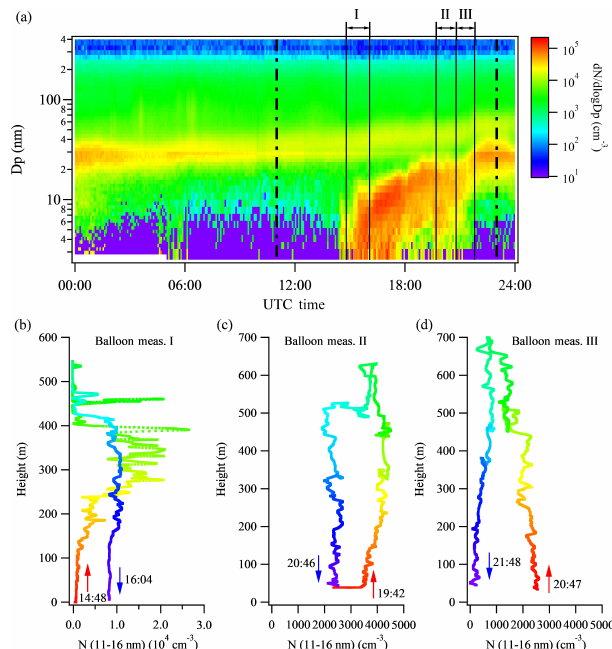
Figure 3. New particle formation event on 12 May 2013 at SGP. (a) Particle size distributions captured by ground-based scanning mobility particle sizers. The two vertical dashed lines represent 06:00 and 18:00 local time, respectively. The vertical black solid lines represent the time frames of the tethered balloon measure- ments. (b–d) Vertical profiles of particle number concentration in the size range of 11–16nm measured by the tethered balloon sys- tem. Three launches were made during the new particle formation event. A rainbow color pattern is used to illustrate the time after the balloon measurements were started, with red representing the initial period and purple representing the final period of a launch.